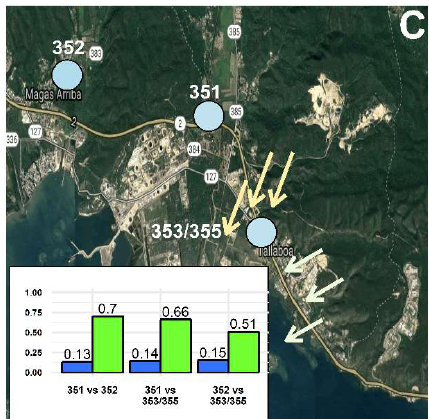
Figure 7. The change in 1 h average NO 2 concentrations across 3 CSAM locations (CSAMs 351, 352, and 353/355) were explored as a function of the following wind conditions observed at the South weather station: inactive ( A ), ocean-originated ( B ), and mainland-originated ( C ). COD (blue bars) and r (green bars) values were recalculated in a pairwise fashion between locations for each wind condition and displayed as a bar chart in the bottom left of Figure 7A–C. Wind conditions at the South, East, and North weather stations are depicted by arrows indicating the median wind direction as a function of the conditions at the South weather station and colored by WS. Each CSAM location in Figure 7A–C are similarly colored based on pollutant concentrations.